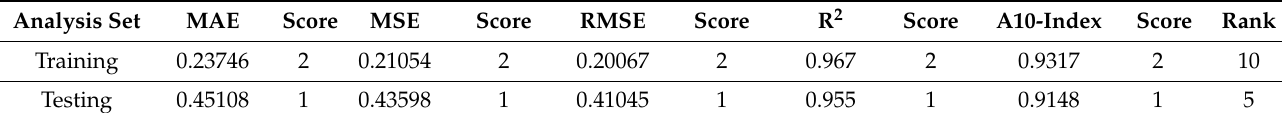
Figure 6. Overlap between the actual and predicted UCS results: ( a ) training set, ( b ) testing set.